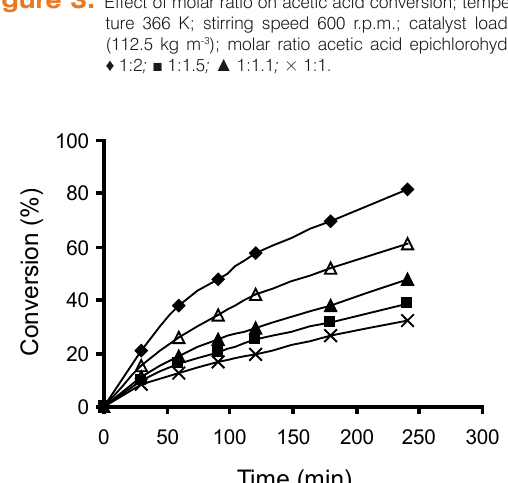
Figure 4. Effect of molar ratio on epichlorohydrin conversion; tem - perature 366 K; stirring speed 600 r.p.m.; catalyst loading (112.5 kg m -3 ); molar ratio acetic acid/epichlorohydrin: ▲ 1.5:1; ♦ 2:1; ■ 1:1.